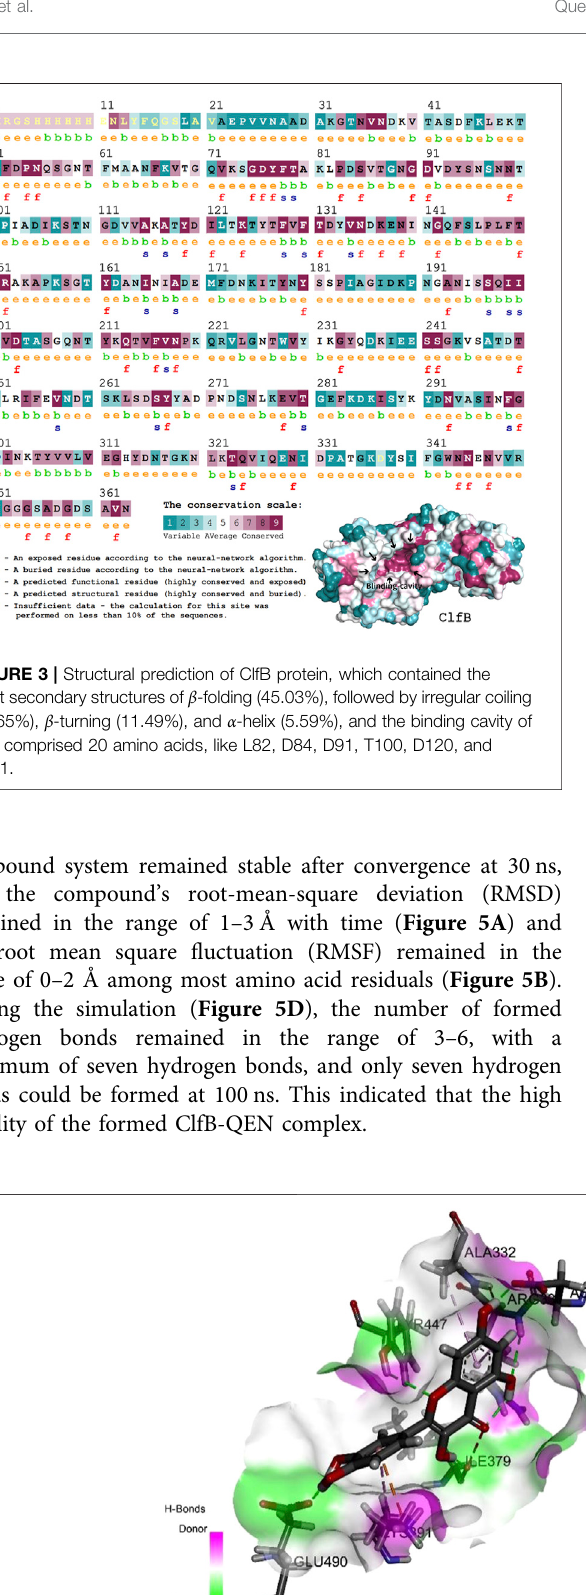
Frontiers in Pharmacology |